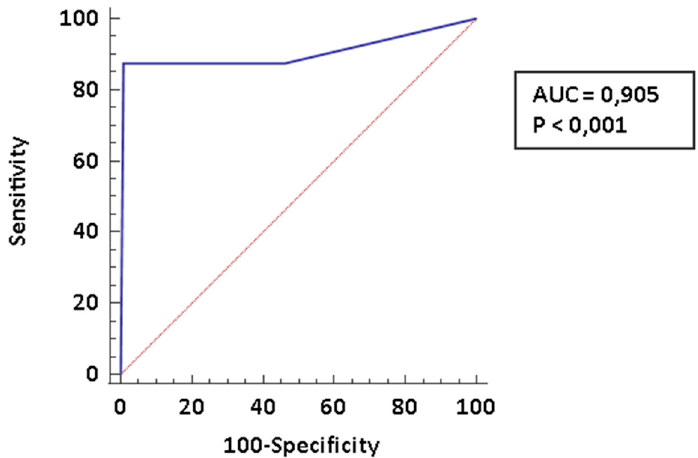
Figure 4. ROC curve for the composite model. We diagnosed 8 CTD-PAH.